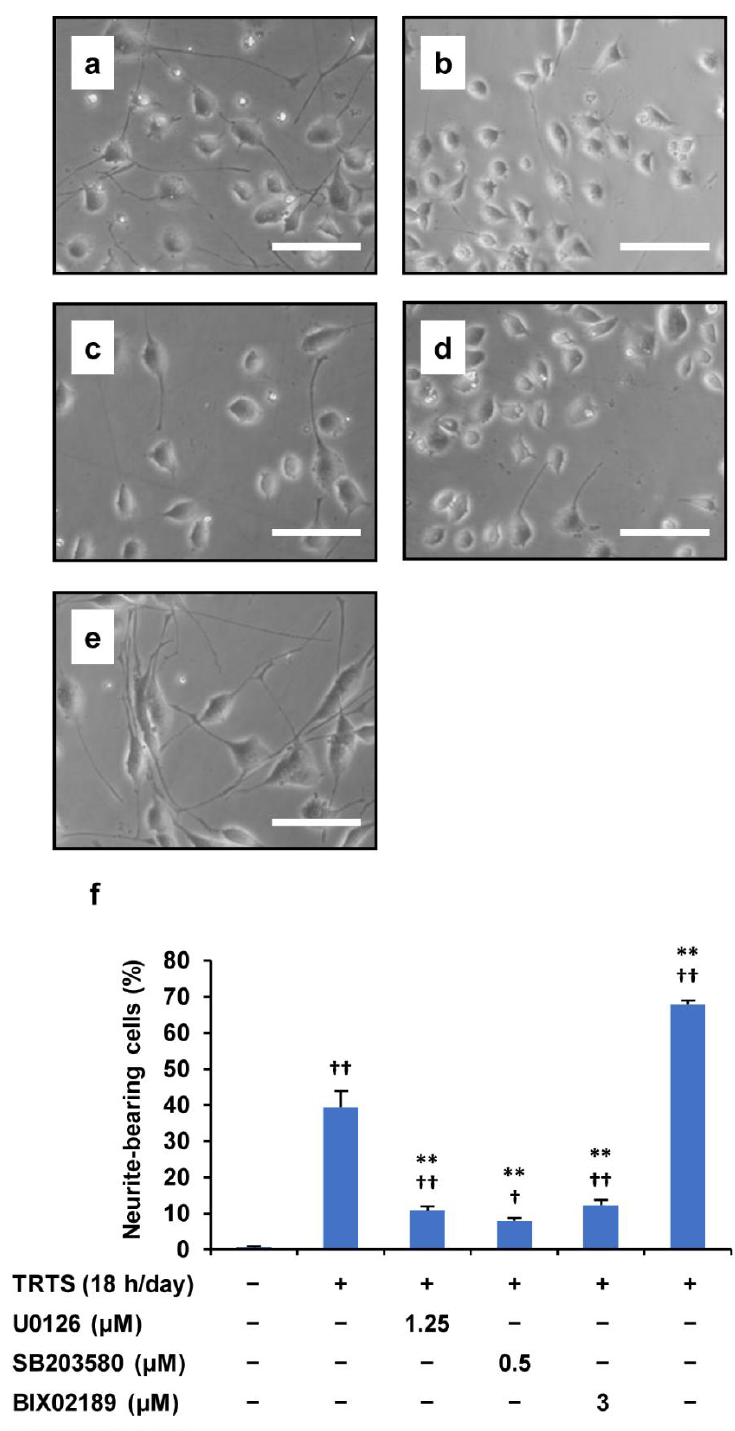
Figure 2. Effect of MAPK inhibitors on TRTS-induced differentiation in PC12-P1F1 cells. PC12-P1F1 cells were pretreated with MAPK inhibitors before TRTS. ( a – e ) Phase-contrast images of the cells on day 7 after TRTS alone ( a ) or pretreated with U0126 ( b ), BIX02189 ( c ), SB2003580 ( d ), or SP600125 ( e ). Scale bars: 100 μm. ( f ) PC12-P1F1 cells were exposed to TRTS for 18 h per day for 7 days with or without pretreatment with MAPK inhibitors, and a control group was incubated with no inhibitor and no TRTS exposure. The percentage of neurite-bearing cells on day 7 was determined. The data represent the means ± standard deviation of three replicates. † p < 0.05 vs. control; †† p < 0.01 vs. control; ** p < 0.01 vs. TRTS alone.